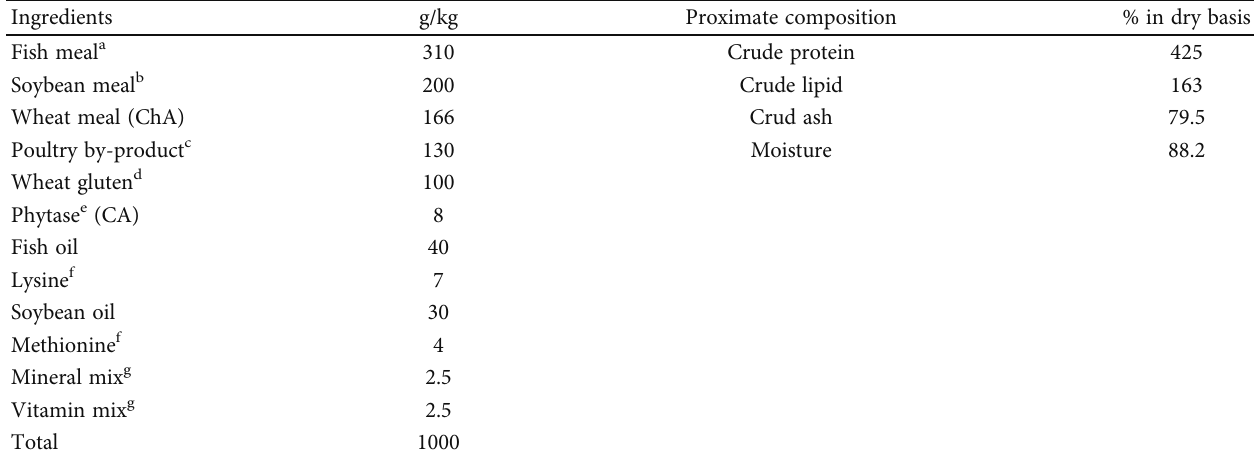
Table 1: Feedstu ff s and compositions of the basal diet